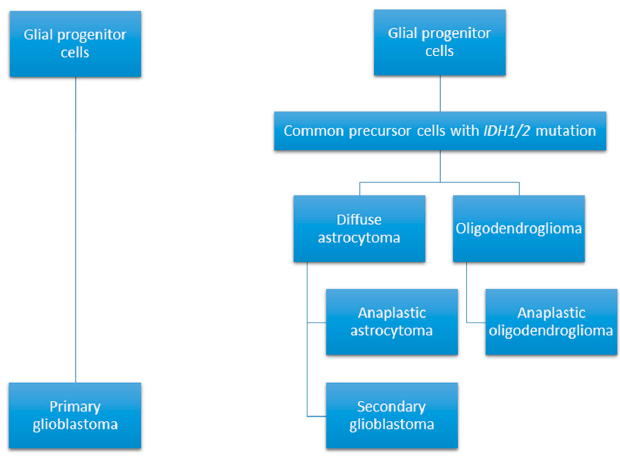
Figure 1. Glioblastomas can develop through two different pathways; arising as a primary malignancy; or through the progression of a lower grade glioma [11].